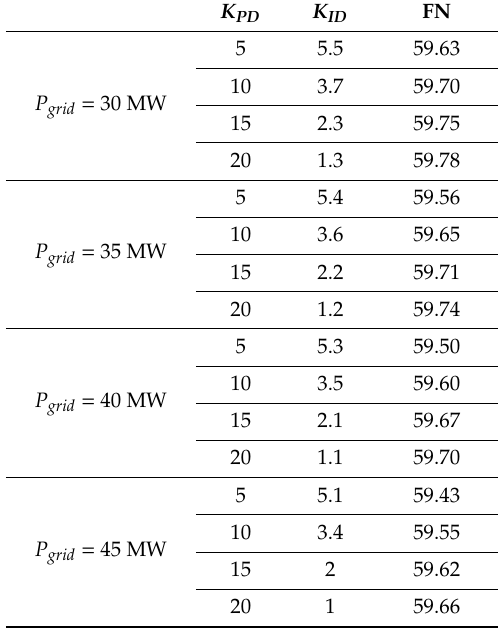
Table 2. The highest frequency nadir for various combinations of K PD and K ID under different values of P grid .